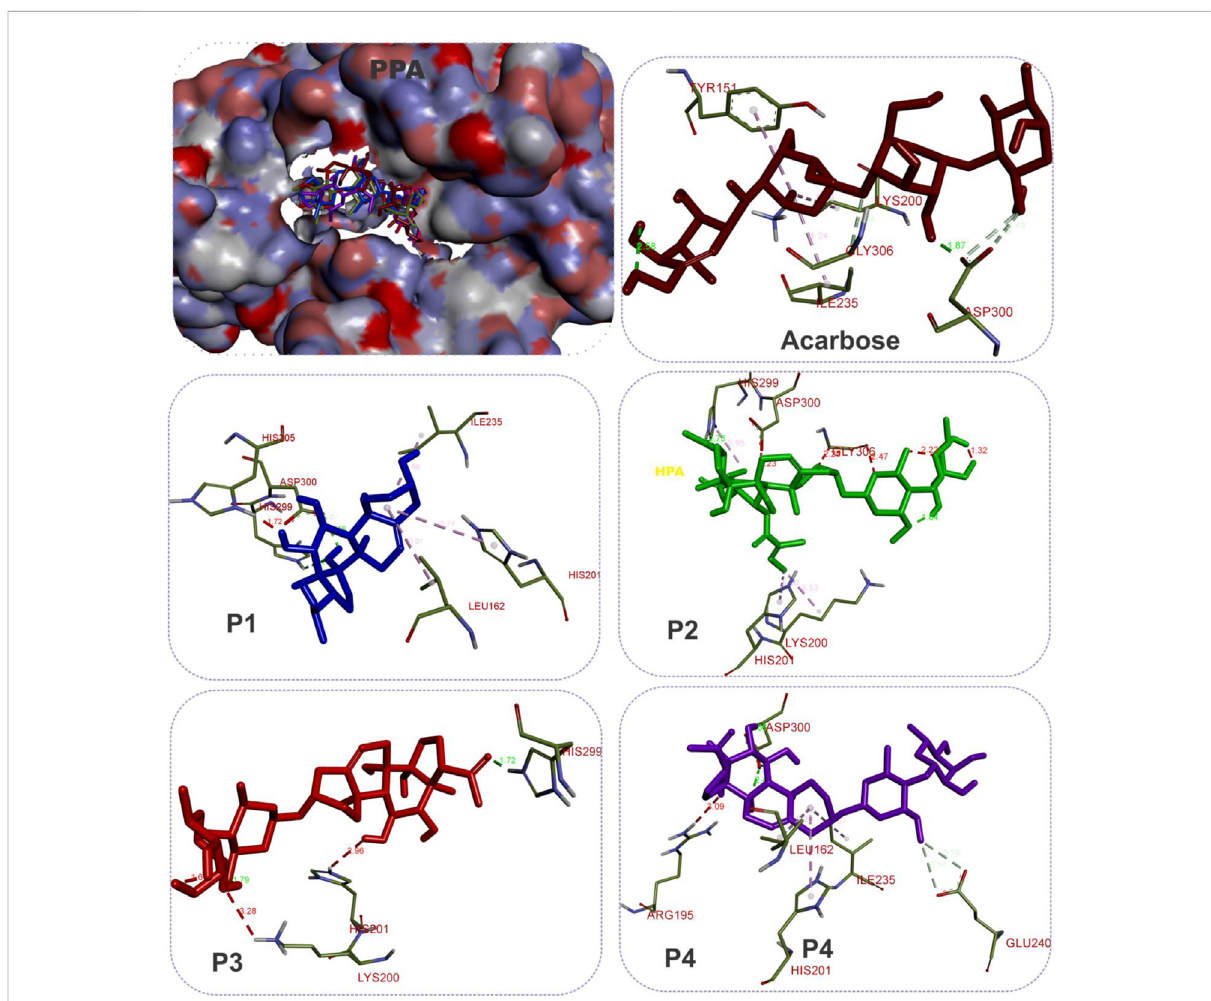
FIGURE 5 The 3D depiction of the interactions of acarbose and the isolated steroidal pregnanes with amino acid residues in the active site of porcine pancreatic alpha-amylase (PPA). Ligands are depicted in stick representations in colors red: acarbose (reference inhibitor); blue: P1; green: P2; pink: P3; purple: P4. Interaction types (dotted lines) and their bond lengths are depicted in green (H-bonds); light purple: hydrophobic interactions (pi- alkyl,alkyl,andpi-stacking);purple:pi-piT-shaped interactions;yellow: pi-sulfurinteractionsandpi-stackinginteractions.Amino acidresidues are in a three-letter representation